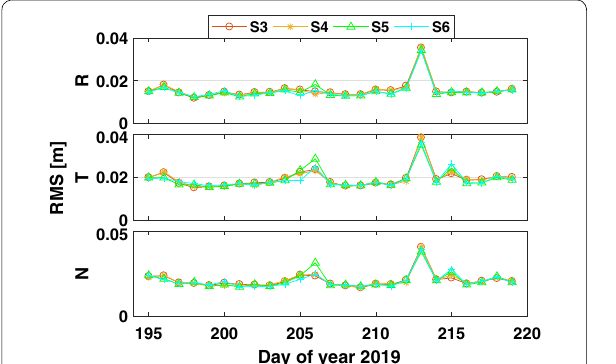
Fig. 5 Average orbit accuracy of each GPS satellite